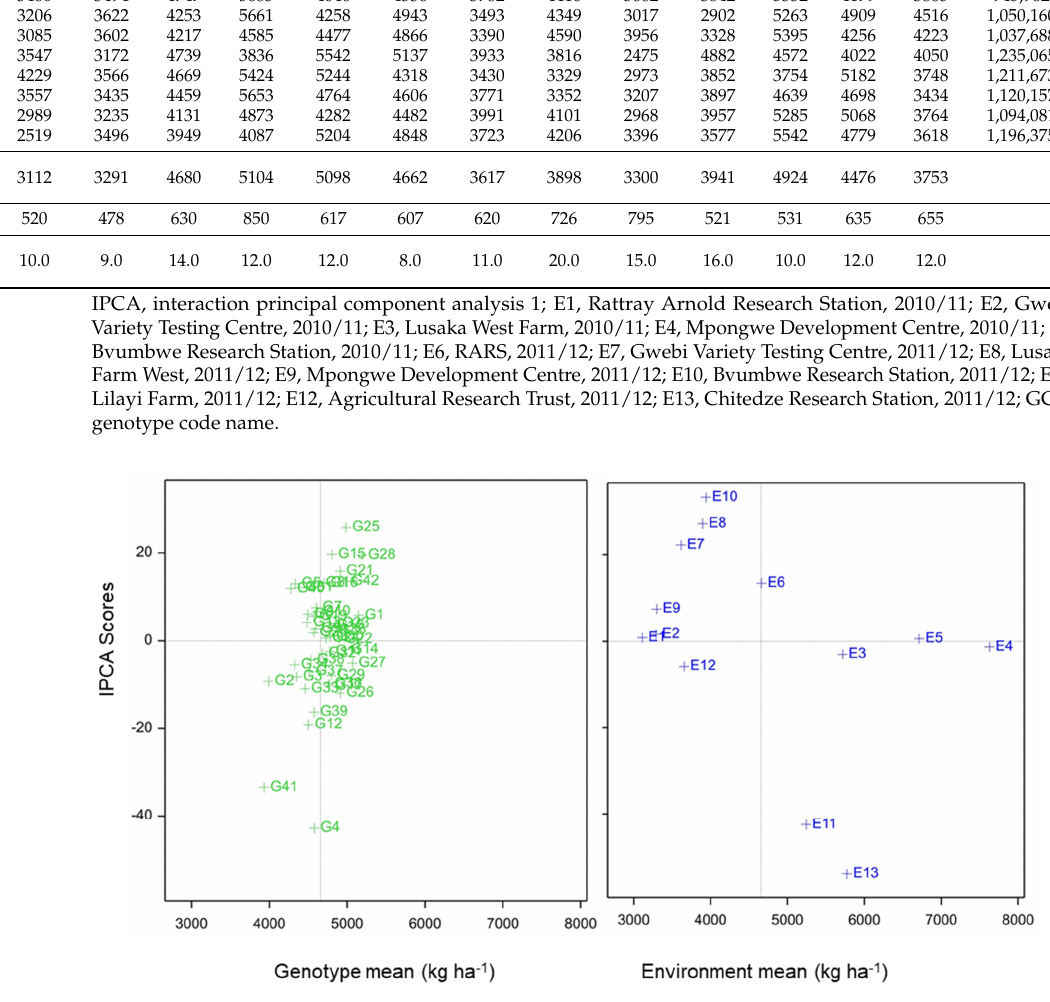
Figure 1. AMMI-1 biplot of IPCA 1 scores against grain yield for 42 soybean genotypes and 13 en- vironments. E1, Rattray Arnold Research Station, 2010/11; E2, Gwebi Variety Testing Centre, 2010/11; E3, Lusaka West Farm, 2010/11; E4, Mpongwe Development Centre, 2010/11; E5, Bvumbwe Research Station, 2010/11; E6, Rattray Arnold Research Station, 2011/12; E7, Gwebi Variety Testing Centre, 2011/12; E8, Lusaka Farm West, 2011/12; E9, Mpongwe Development Centre, 2011/12; E10, Bvumbwe Research Station, 2011/12; E11, Lilayi Farm, 2011/12; E12, Agricultural Research Trust, 2011/12; E13, Chitedze Research Station, 2011/12; G1 to G42 represent the test genotypes.